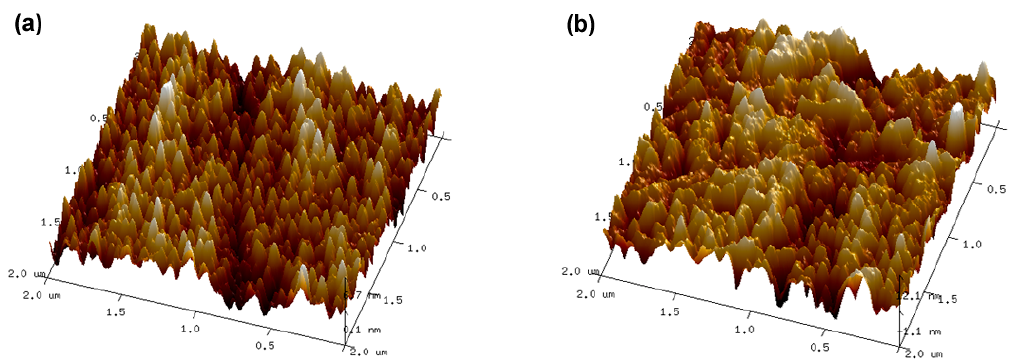
Figure 5. AFM surface morphologies of the component layers: ( a ) TiN interlayer; ( b ) SiO x layer.